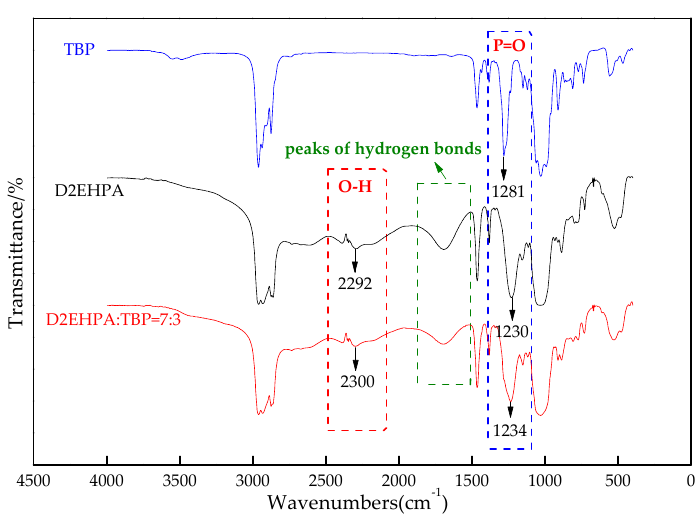
Figure 9. Fourier transform infrared spectra (FT-IR) spectra of TBP, D2EHPA, and mixture of D2EHPA to TBP = 7:3.